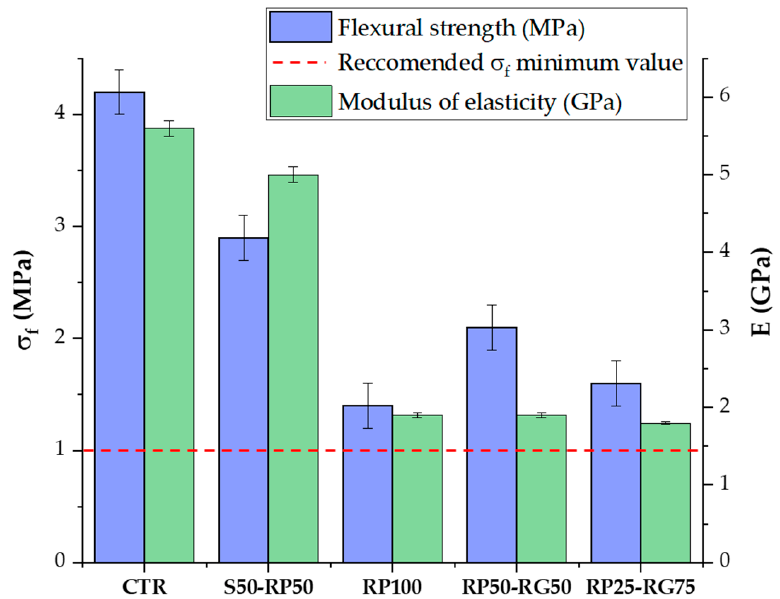
Figure 12. Flexural strength and modulus of elasticity: Test results. Dispersion lines in the plot represent the standard deviations.